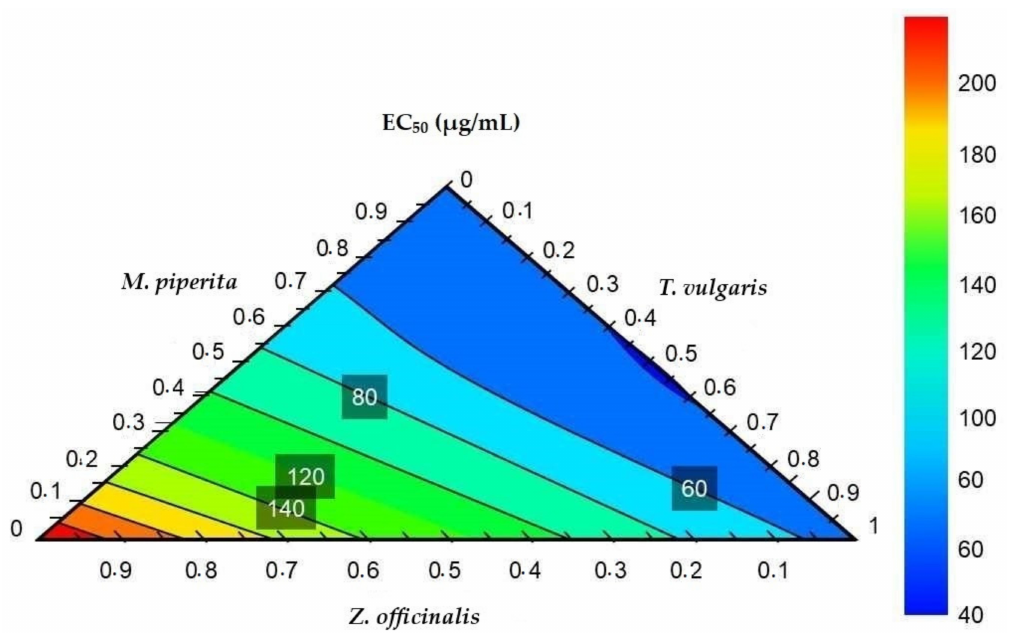
Figure 3. Response contour plot.